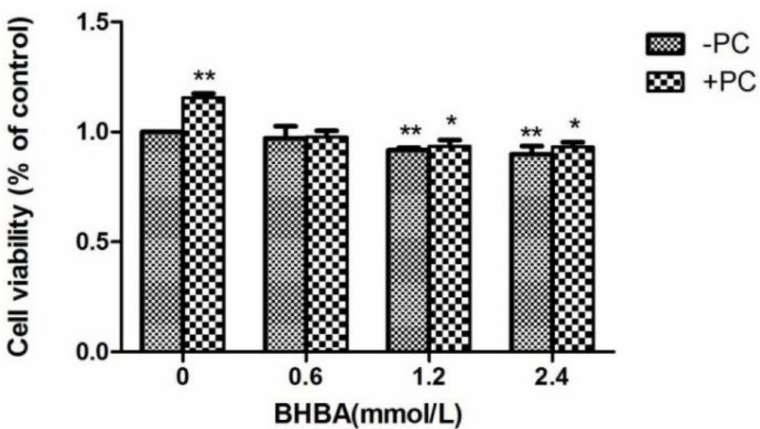
Figure 3. Effects of different BHBA concentrations and fixed PCs concentration of 10 µ mol/L on relative viability of simultaneously treated BEND cells. * p < 0.05 vs. control group, ** p < 0.01 vs. control group.